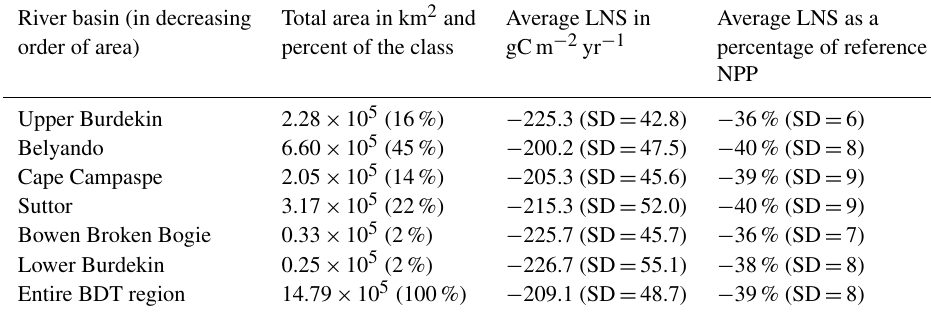
Table 4. Degraded LNS class. Area, severity, and variation in LNS and LNS percent. SD – standard deviation. River basin (in decreasing Total area in km 2